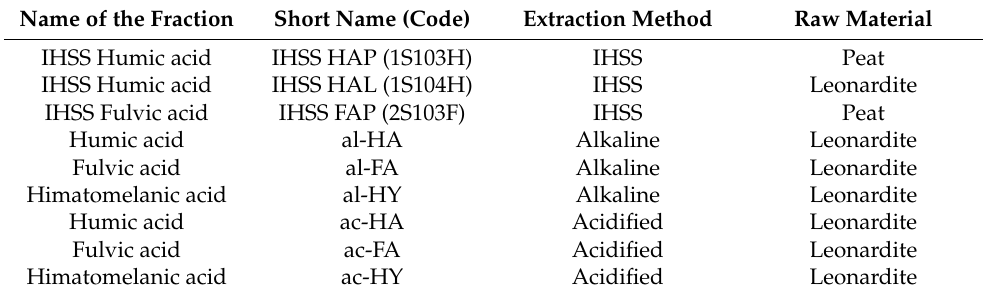
Table 1. The names, the short names, extraction method, and the raw material of the samples. Name of the